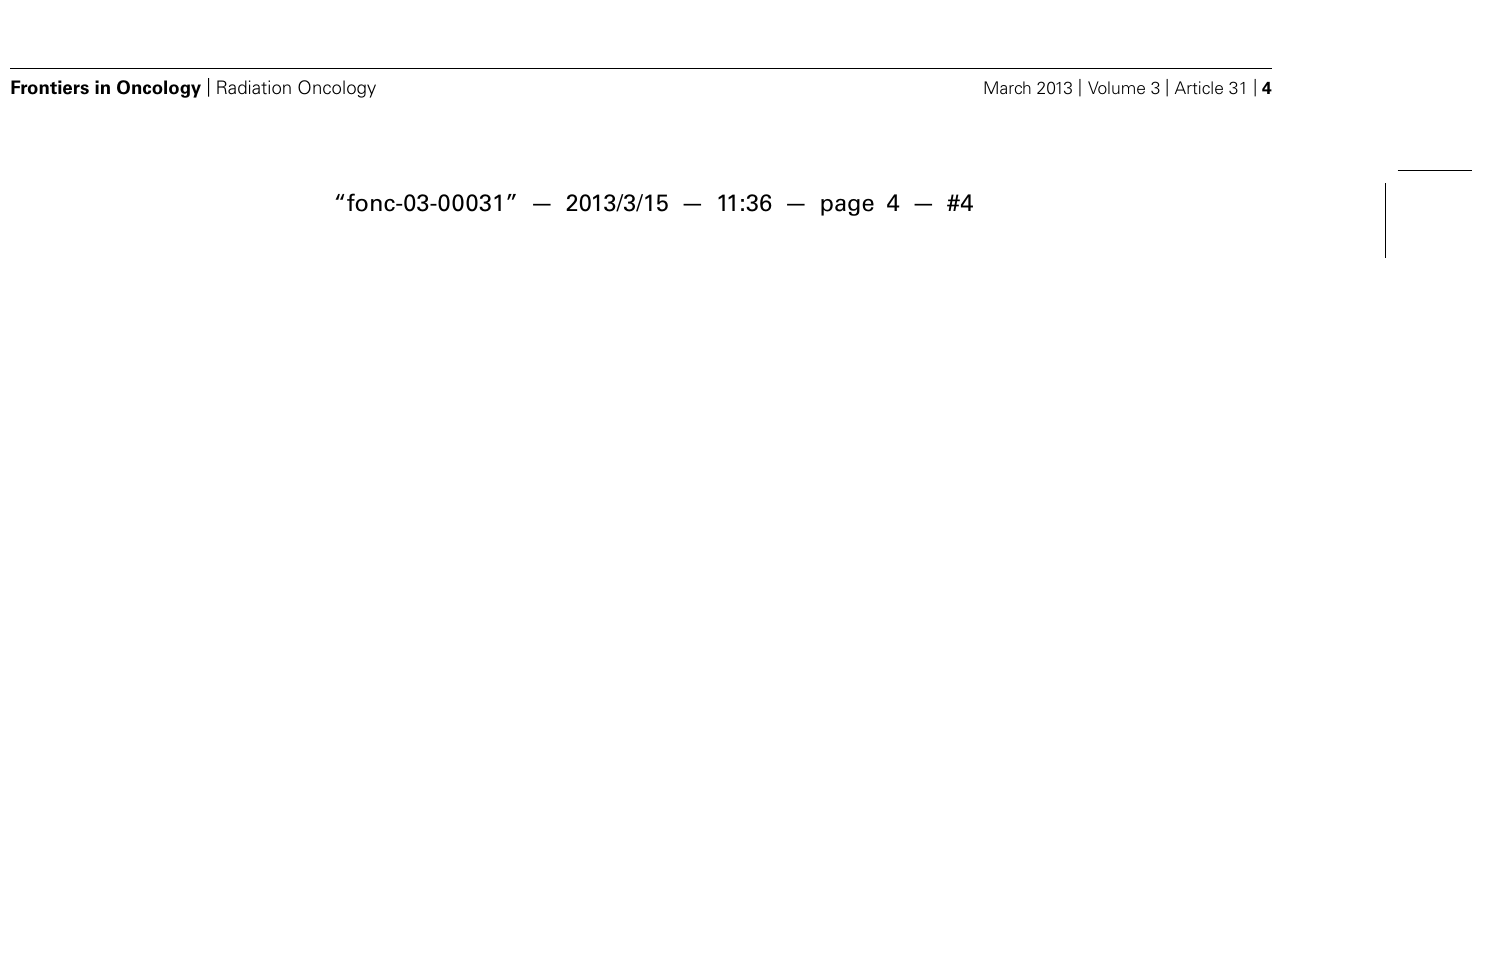
Frontiers in Oncology | Radiation